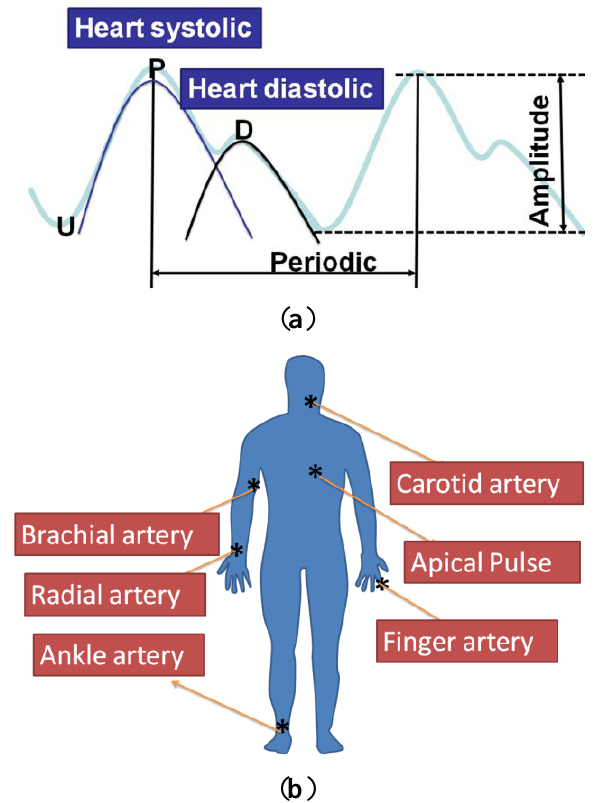
Figure 7. ( a )The heart systolic to diastolic and to produce the general human pulse waveform ( b ) the PZT tactile sensor to measure the human body artery pulse